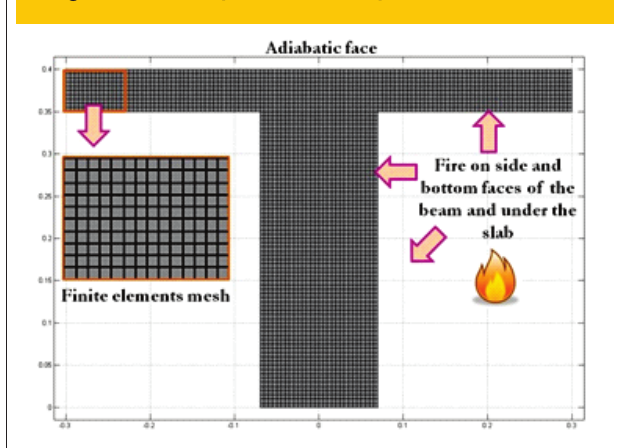
Figure 2 – Example of the adopted beam model Figure 3 – Field of temperatures within